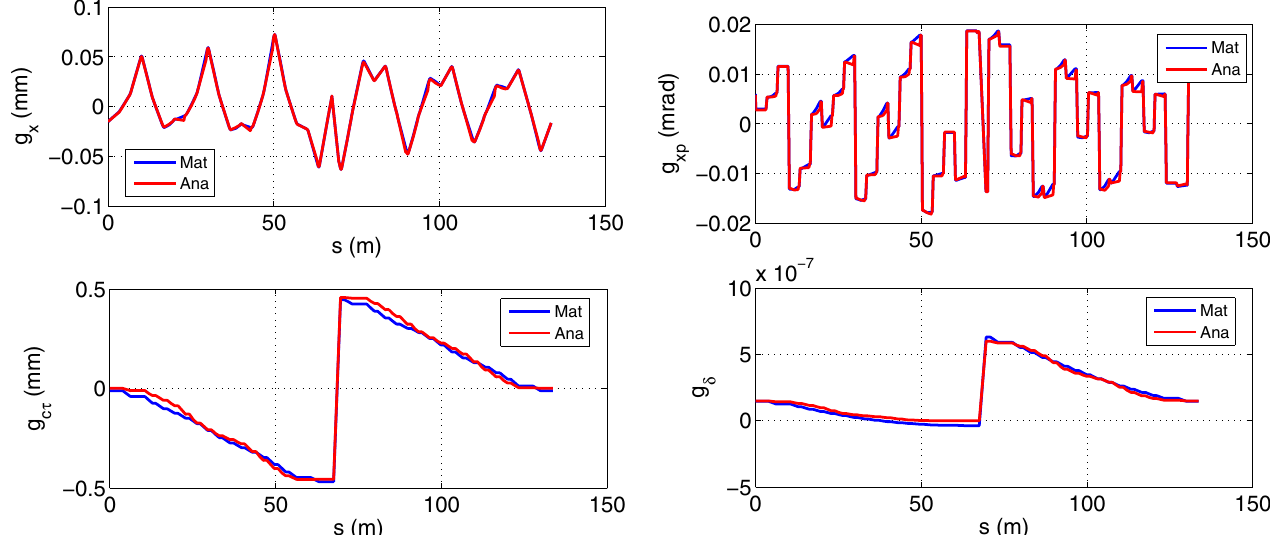
FIG. 3. (Color) The one-turn coordinate shifts due to radiation energy losses and finite energy gains at the rf cavity for the SPEAR Booster at 3 GeV. The four plots are x , x 0 , c(cid:2) , and (cid:3) shifts, respectively.